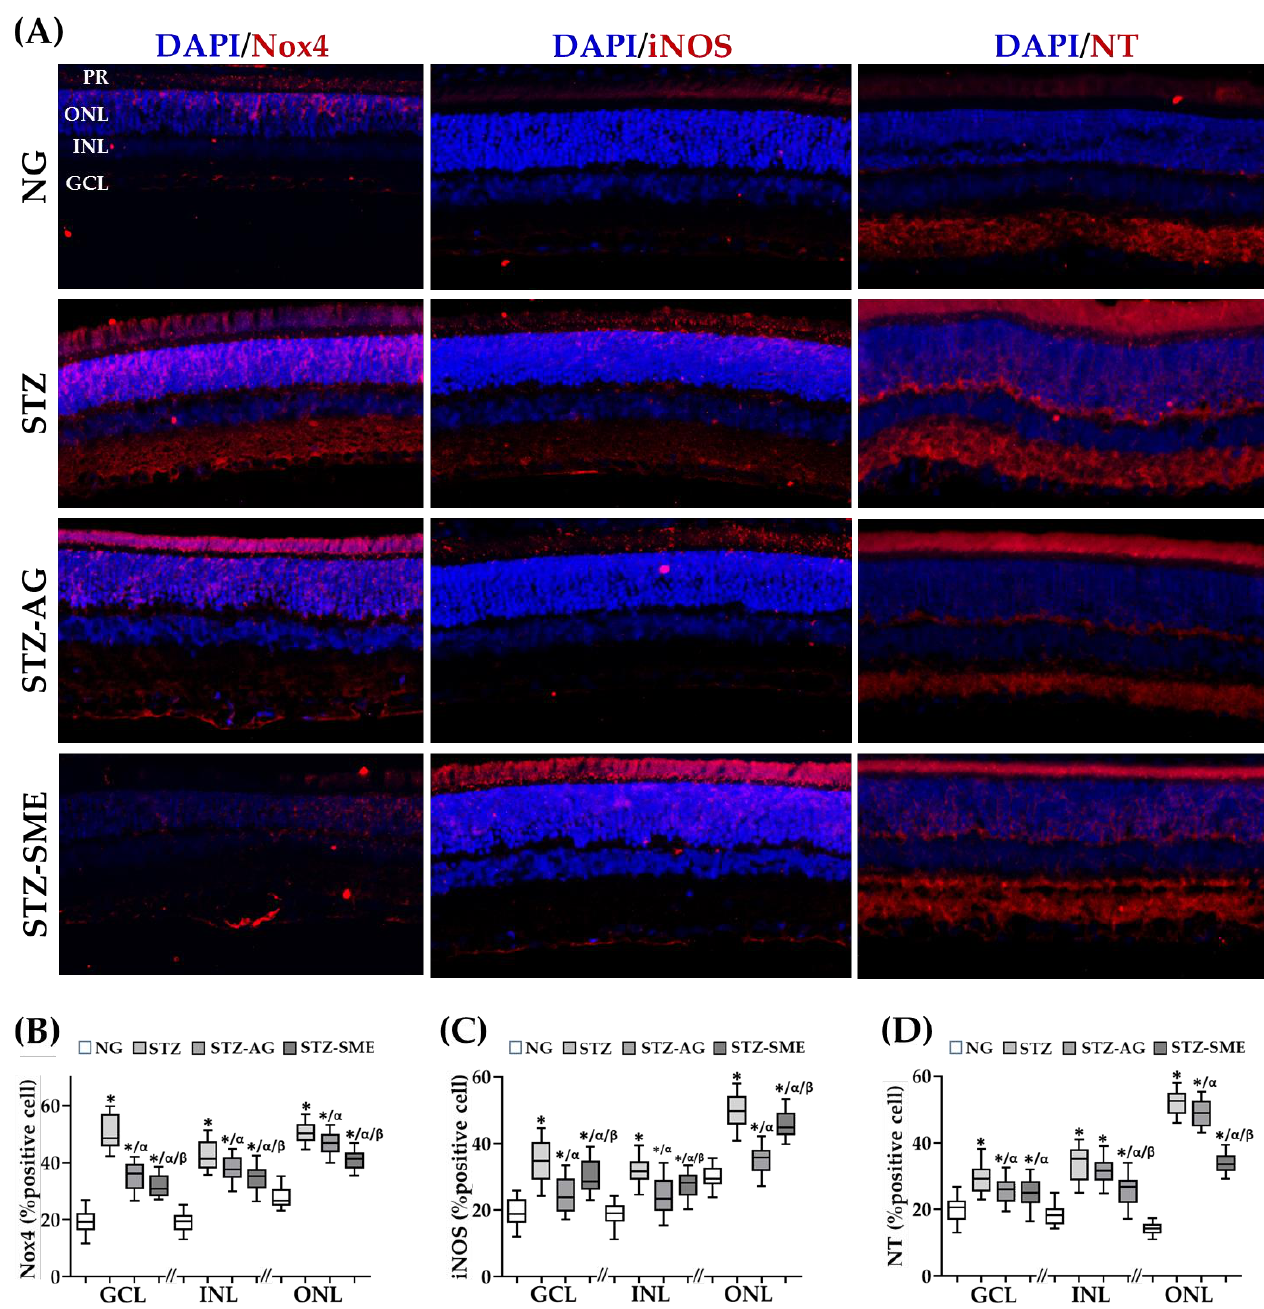
Figure 2. Antioxidant effect of SME in the retina of STZ. ( A ) Representative micrographs of immunofluorescence for NADPH oxidase 4 (Nox-4) ( A ), inducible nitric oxide synthase (iNOS), and nitrotyrosine (NT). ( B – D ) show the box-and-whisker plots of the percentage positive cells in GCL, INL, and ONL for each immunostaining in NG, STZ, STZ-AG, and STZ-SME groups. The nuclei were stained with DAPI (blue). * p < 0.01 compared to NG; α p < 0.05 compared to STZ; and β p < 0.01 compared to STZ-AG. Magnification 200 × . In supplement 3, DAPI and each specific antibody stain are shown in a single-channel and the fused